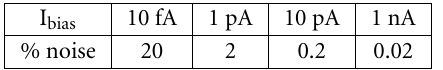
three orders of magnitude over analog SP techniques (Ramakrishnan et al., 2012). The second approach was based on a local, configurable architecture (FPGA/FPAA) for routing neurons with a high percentage of local